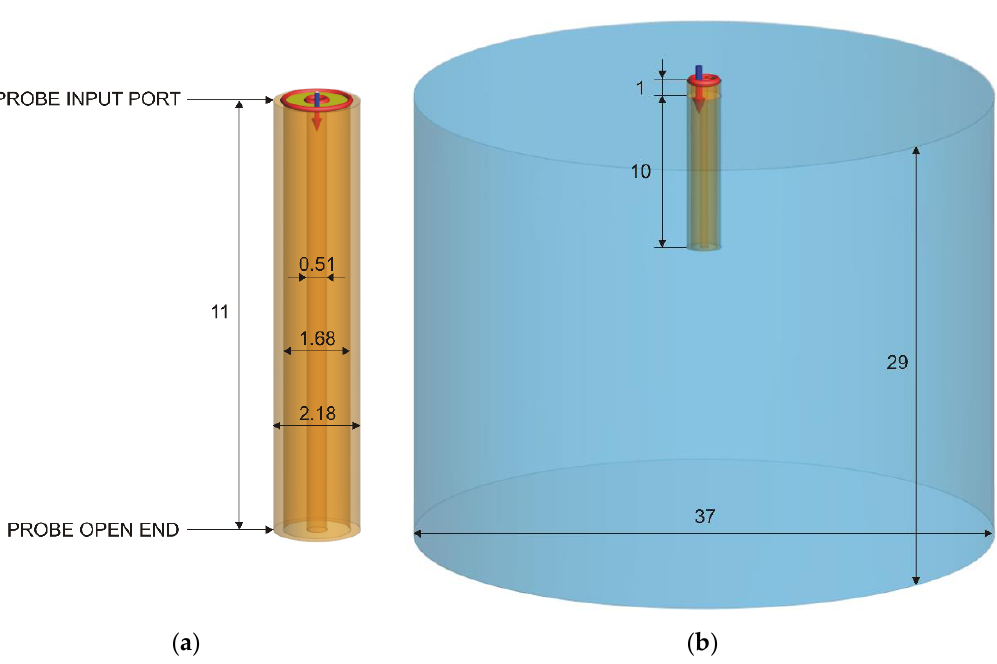
Figure 2. ( a ) The slim-form probe modeled as a coaxial line. ( b ) The model showing the probe in- serted 10 mm deep into the MUT, with its input port outside the MUT. All measurements in milli-